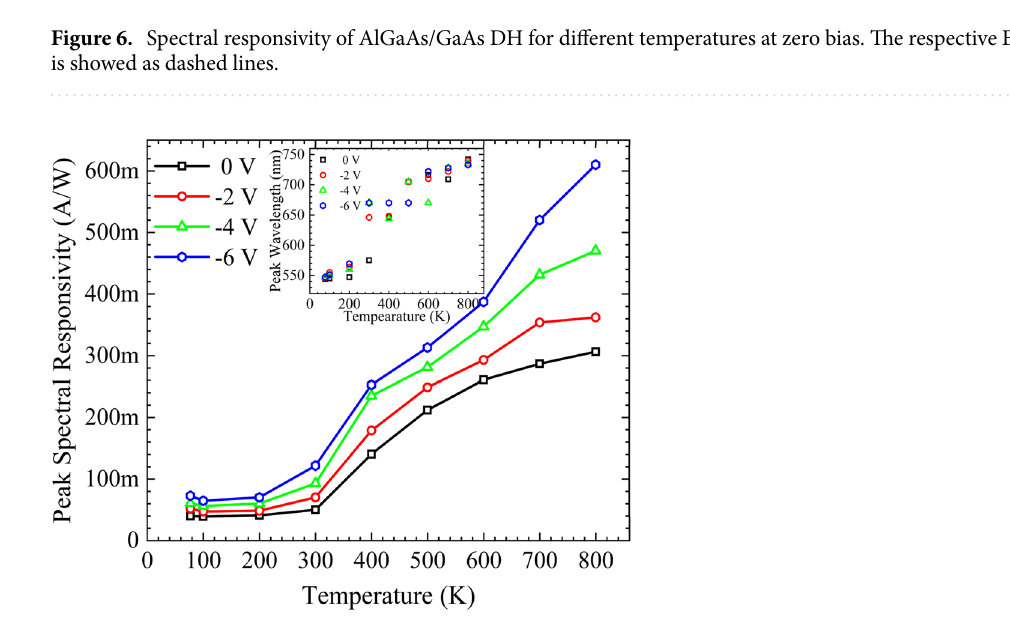
Figure 7. Peak spectral responsivity of the AlGaAs/GaAs DH for different biased conditions. Inset shows the redshift of peak responsivity with respect to